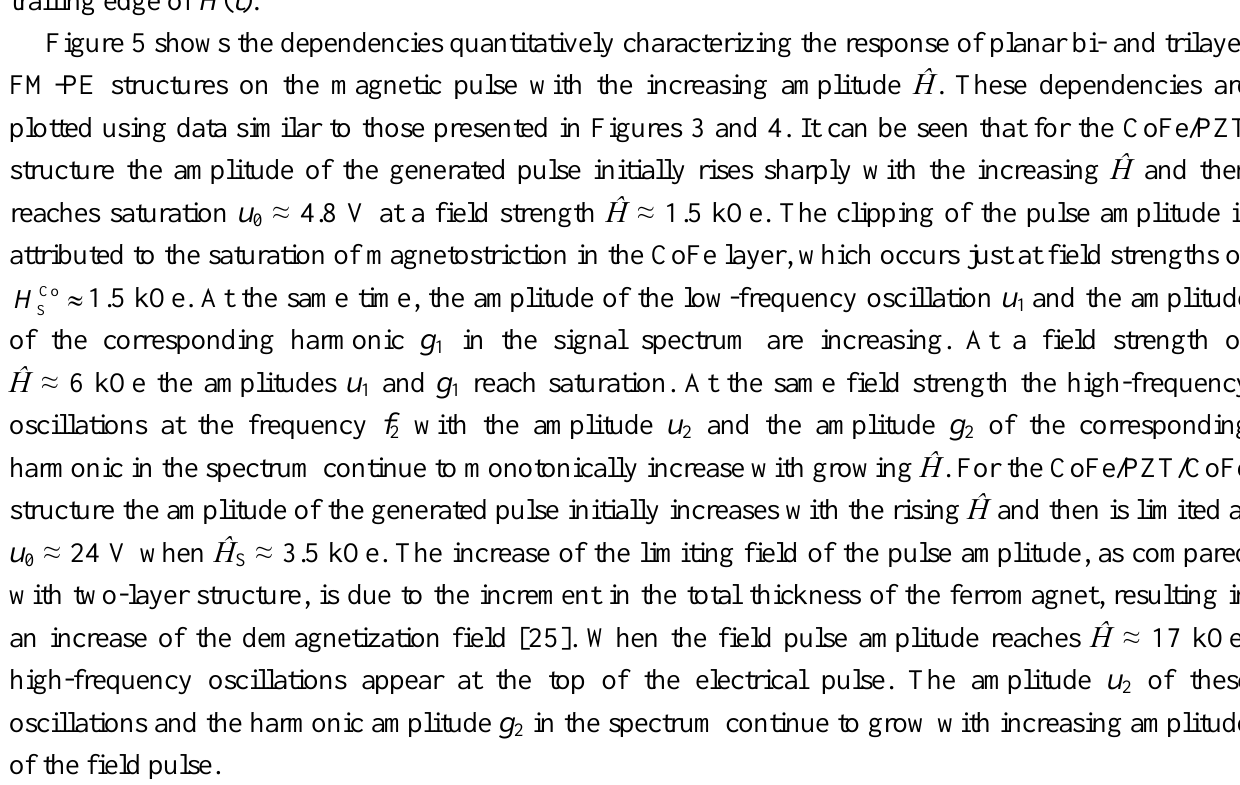
, u , u ) and the 0 1 2